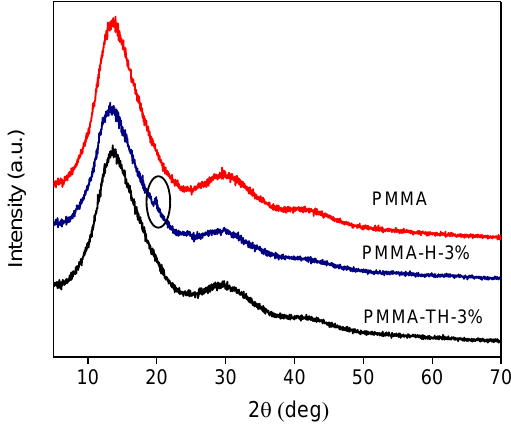
Figure 5. XRD diffraction patterns of PMMA and PMMA/reactive halloysite nanocomposite.